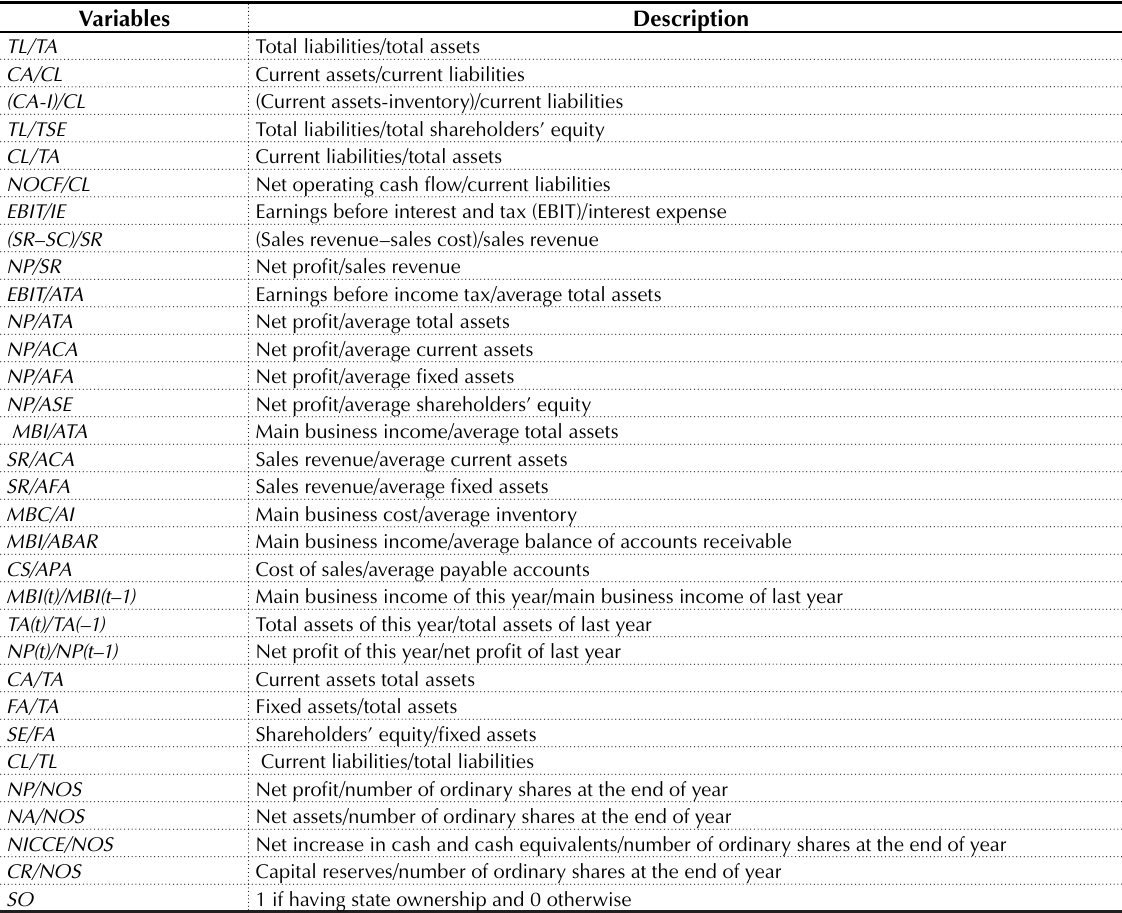
Table A1. List of independent variables – variable set 1